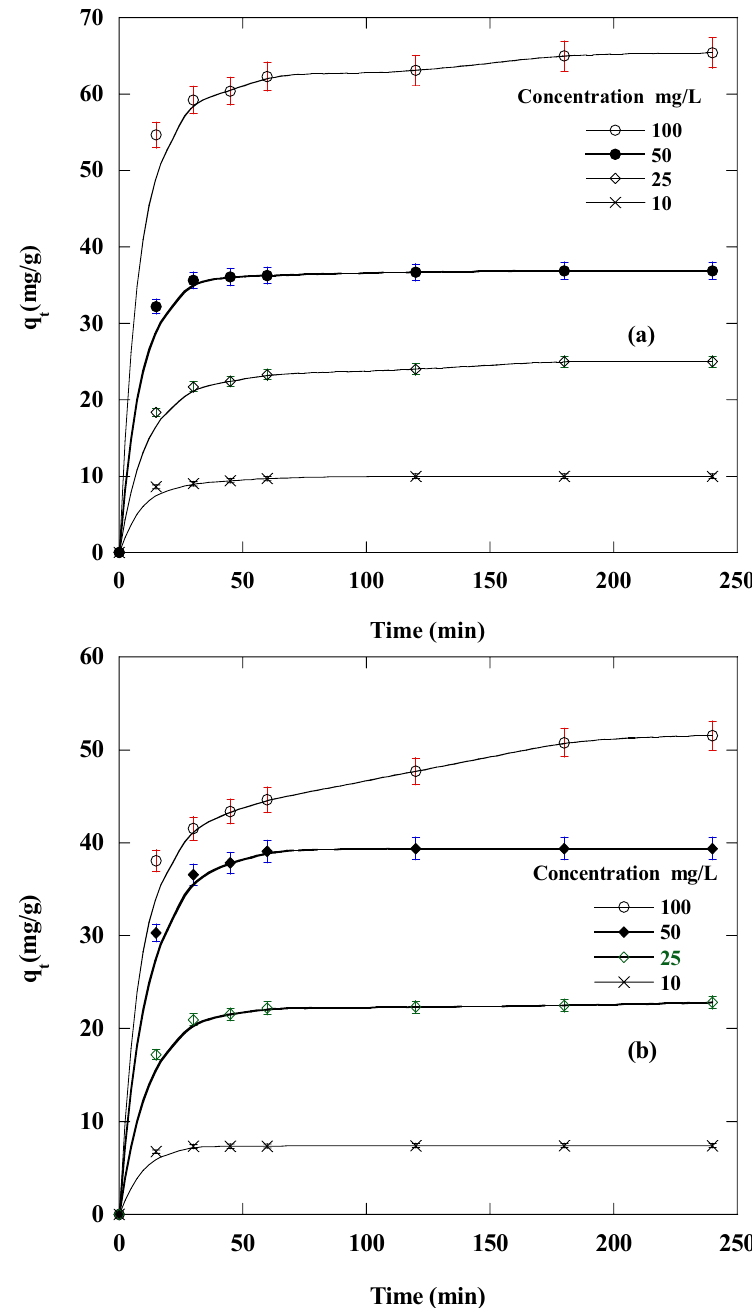
Figure 7. Effect of dye concentrations and contact time on the amount of dye adsorbed at 20 °C and pH 6 by 50 mg of new nano-biosorbents ( a ) CF and ( b )